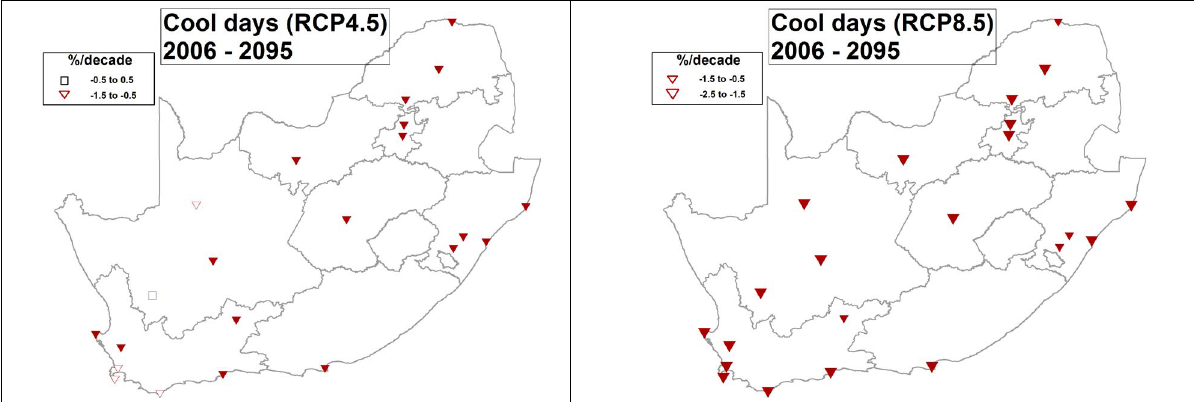
Figure 7: Trends in annual number of cool days (TX10P) in % per decade, for the period 2006–2095 for the RCP4.5 and RCP8.5 scenarios, as indicated. Filled triangles denote significant trends at the 5%